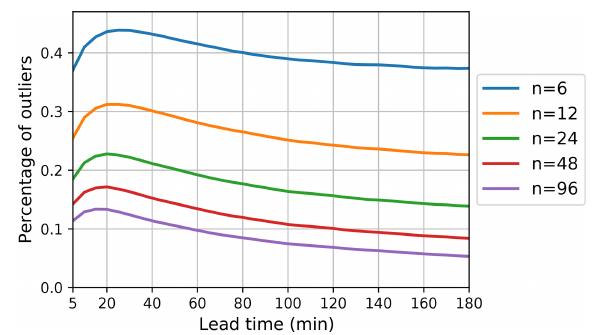
Figure 14. Outlier percentages (OPs) with different ensemble sizes as a function of lead time during the MeteoSwiss events listed in Table